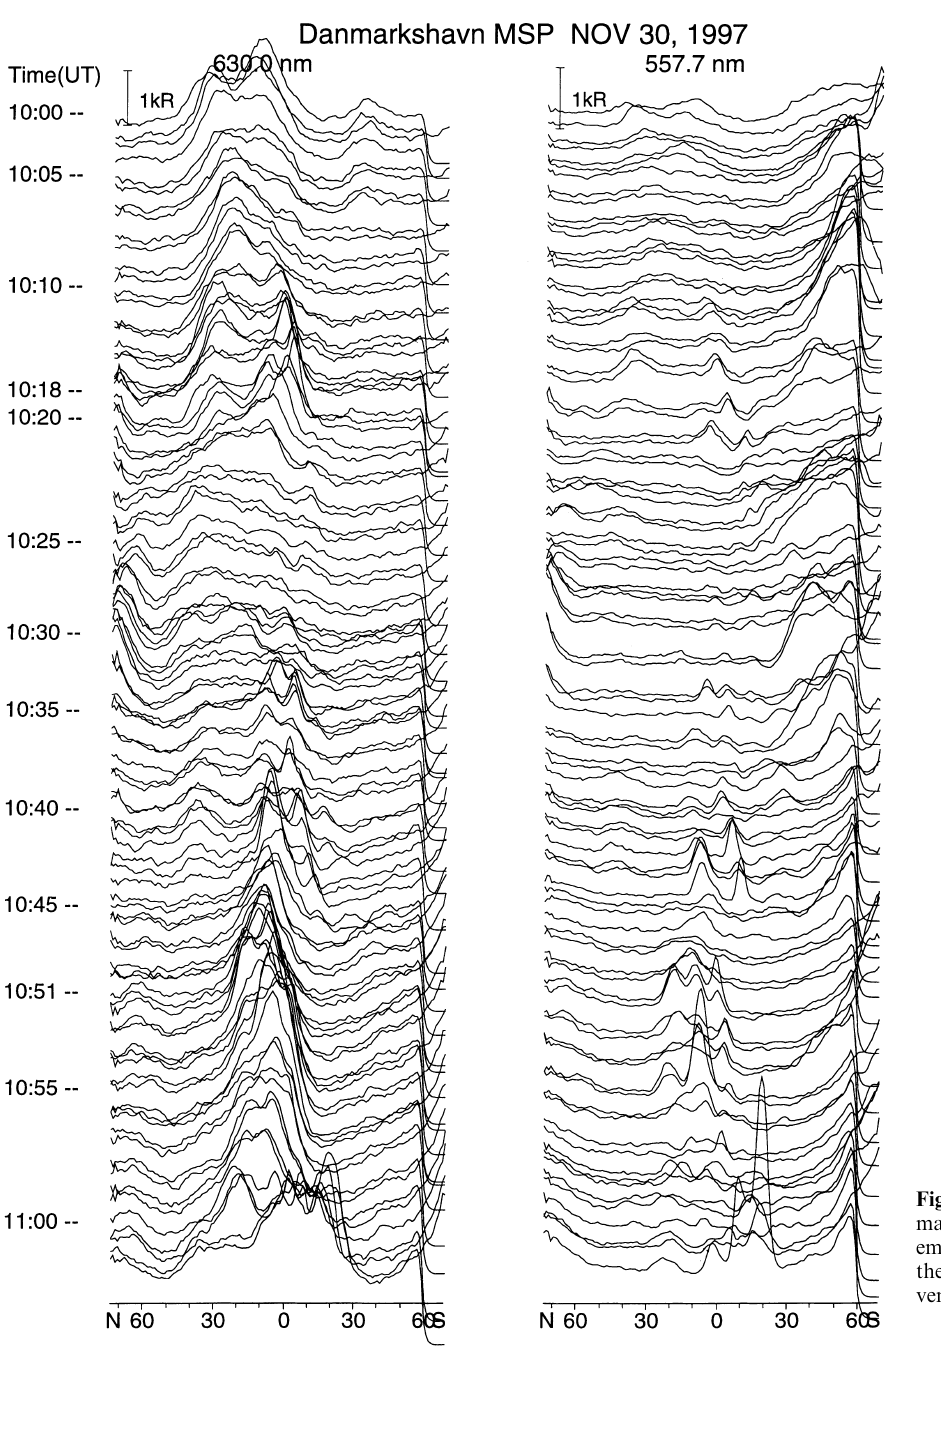
Fig. 5a–c. False color representation of all-sky auroral images at 630 nm for the intervals a 1039–1054 UT, b and c 1100, 1102, 1104, 1106, 1112, and 1117 UT on 30 November, 1997. Figure a, b shows auroral images projected to an Earth-centered sphere at 250 km altitude. The reference frame is geographic coordinates. Latitude circles at 70 (cid:14) and 80 (cid:14) as well as meridians separated by 10 (cid:14) are shown. c shows unprojected images in zenth angle-azimuth angle plots. Geographic north (N) is at the top and east (E) to the right in these images. The photometer scanning meridian is indicated by white arrowed line